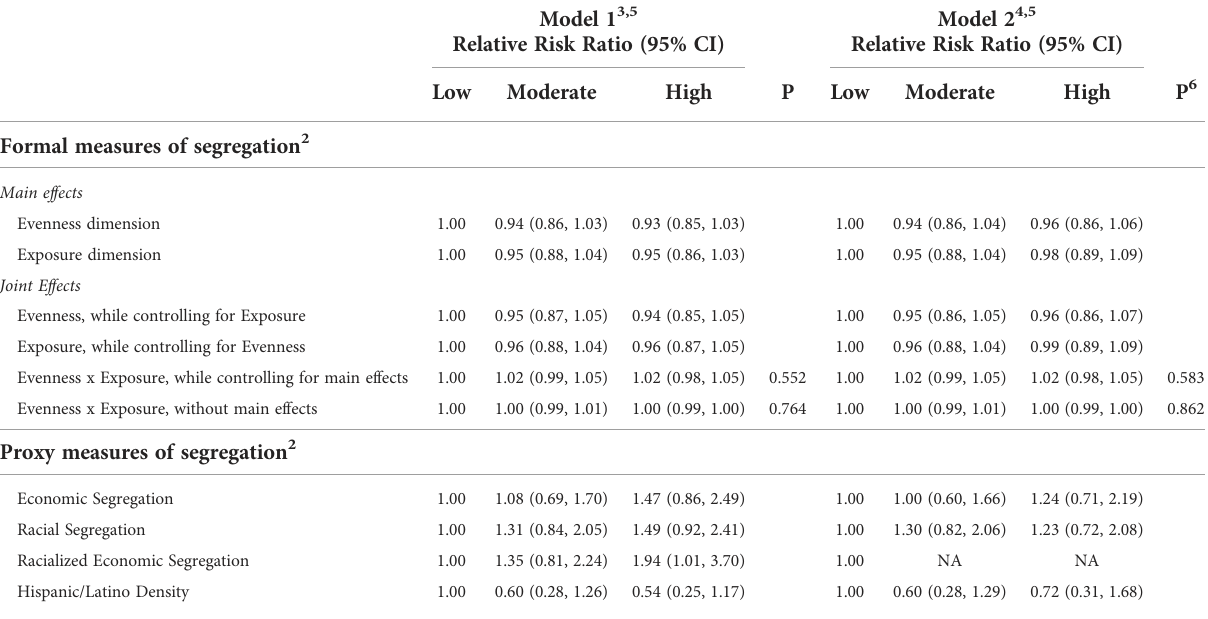
TABLE 6 Multinomial logistic regression models for the association between neighborhood segregation measures and adherence to the ACS guidelines 1 on nutrition and physical activity for cancer